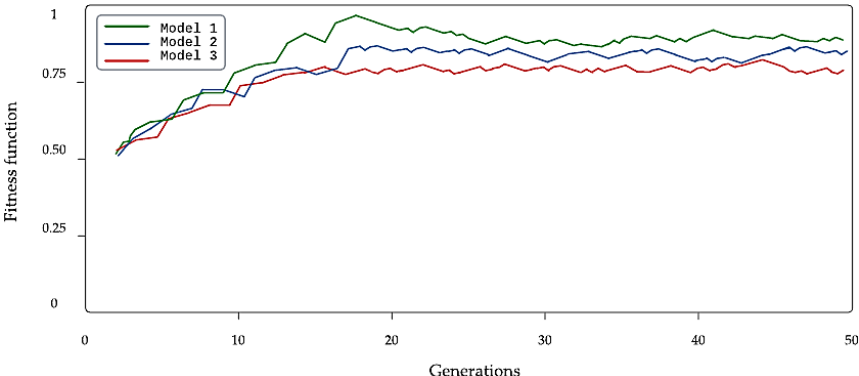
Figure 6. Evolution and convergence of the GA at 50 generations.